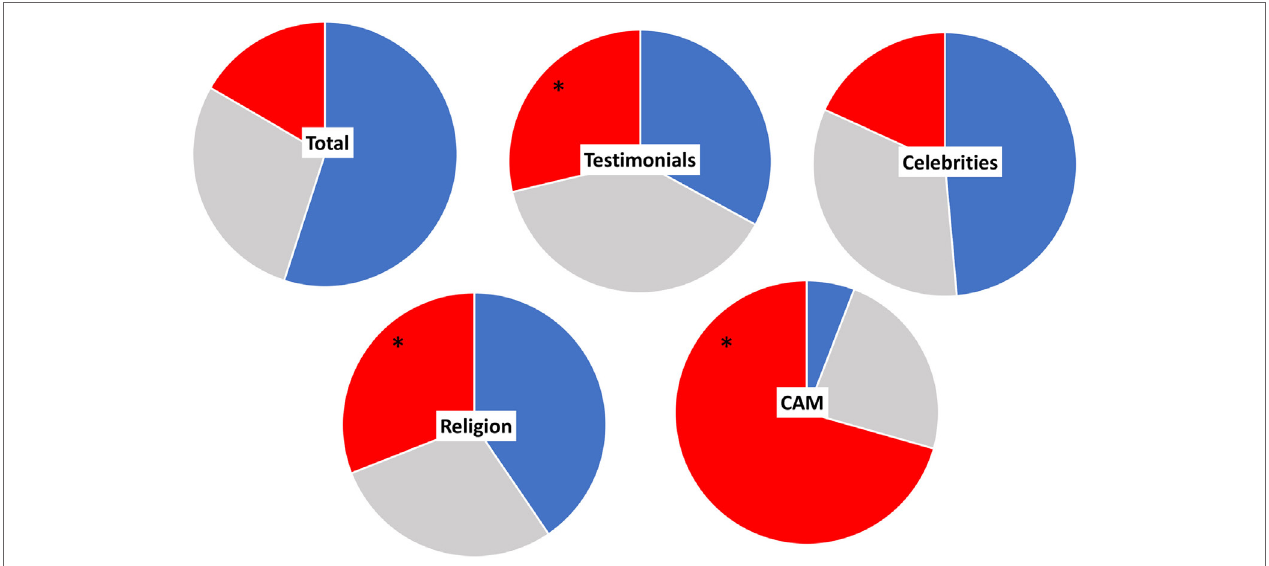
FigUre 4 | Vaccine stance in webpages from all search engine result page (SERPs) mentioning testimonials, celebrities, religion, or complementary and alternative medicine. Blue, vaccine-positive, gray, neutral, red, negative. * Denotes a higher frequency of vaccine-negative webpages compared to the total SERP ( P < 0.05 by Fisher’s test).